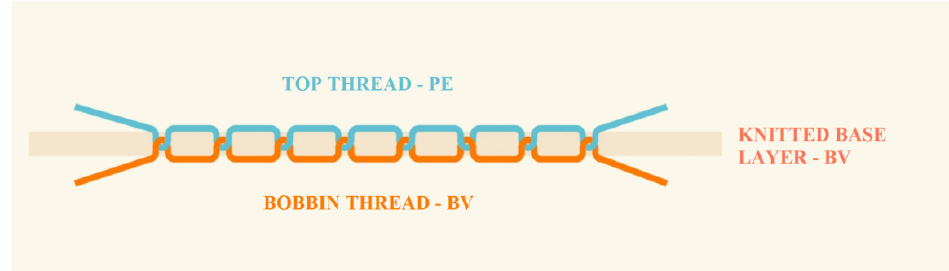
Figure 2. Schematic of the embroidery structure.